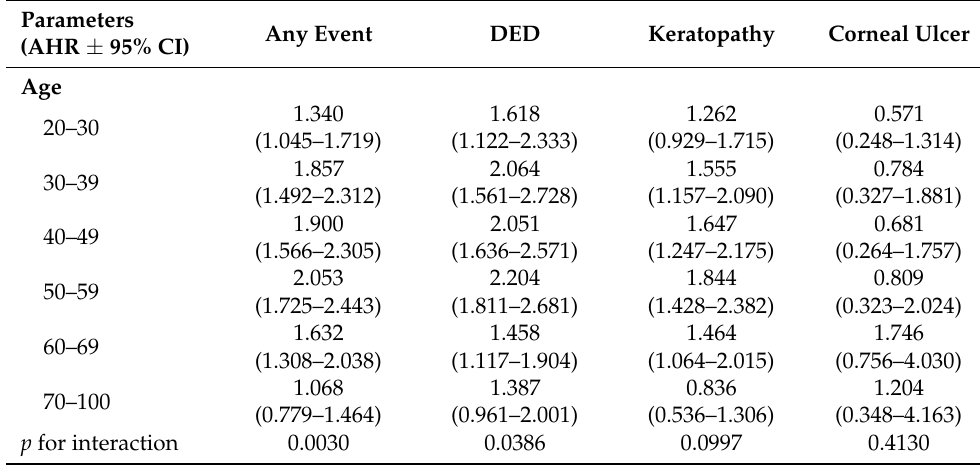
Table 3. Stratified analysis via age and gender in ankylosing spondylitis population. Parameters